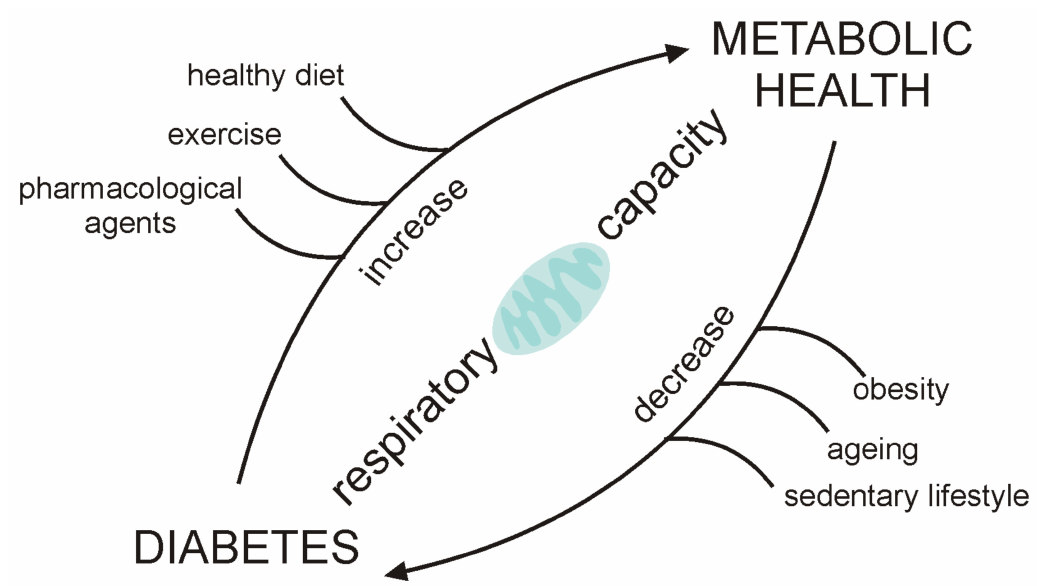
Figure 3. Mitochondria as an effector target of main diabetogenic factors such as obesity, aging and sedentary habits, which all cause a decrease of respiratory capacity, while the lifestyle and pharmacological interventions cause an increase of respiratory capacity and improvement of metabolic